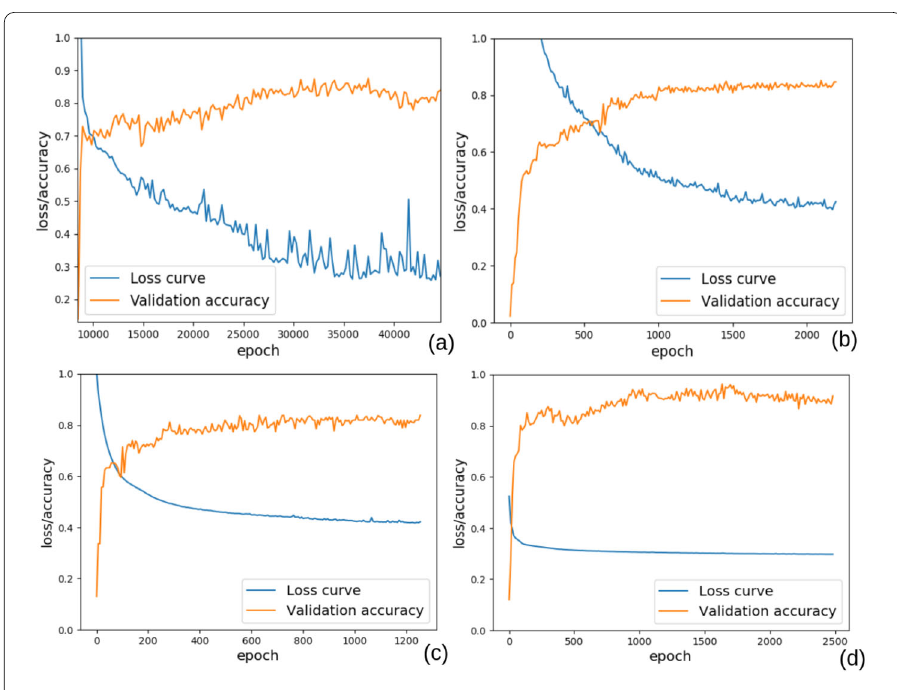
Figure 11 Loss function and accuracy vs. number of epochs for the training of the neural network, with ( b , d ) and without ( a , c ) data augmentation, and using the morphological ( a , b ) and spherical harmonics ( b , d )